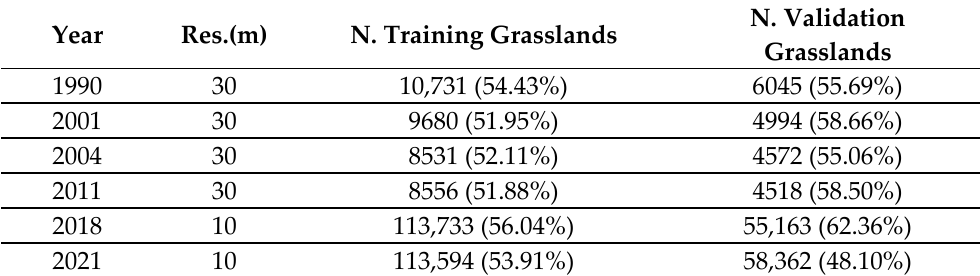
Table 2. Total number of grasslands pixels selected in each year for training and validation. The percentages in columns 3 and 4 are related to the whole multi-class training and validation dataset,